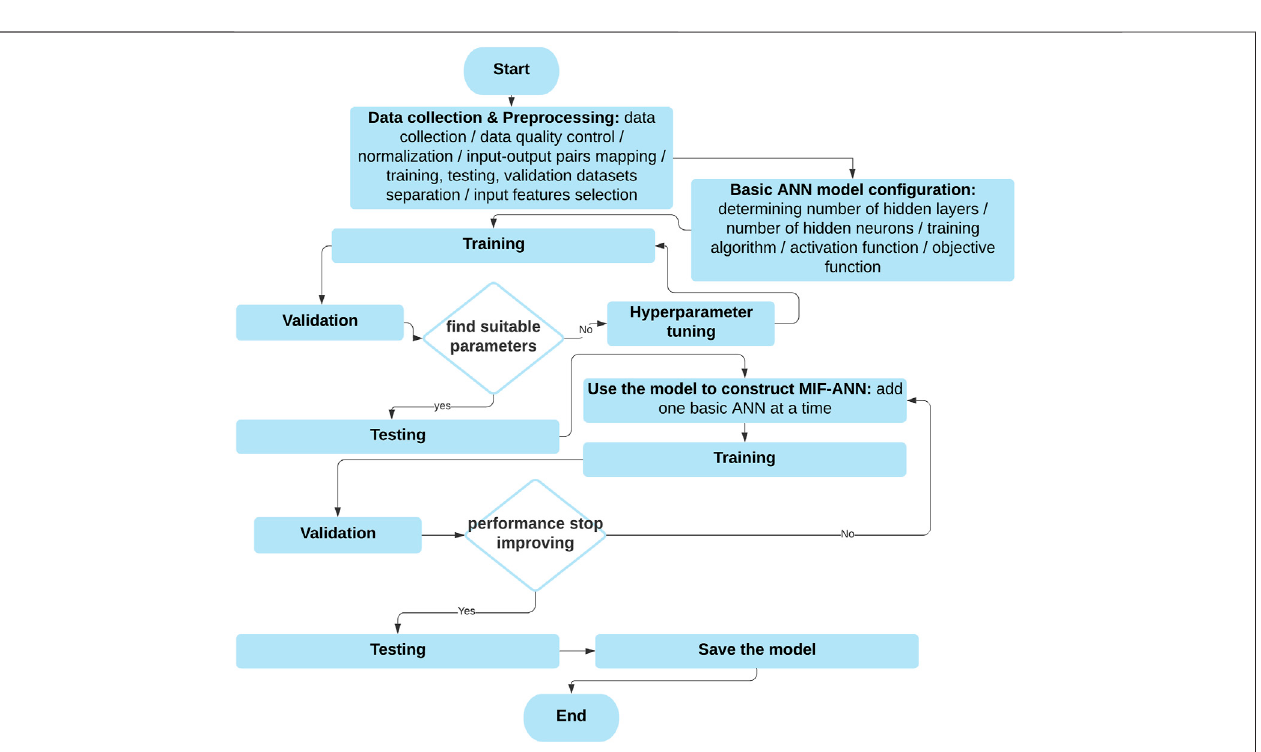
FIGURE 1 | Flowchart of the methodology.